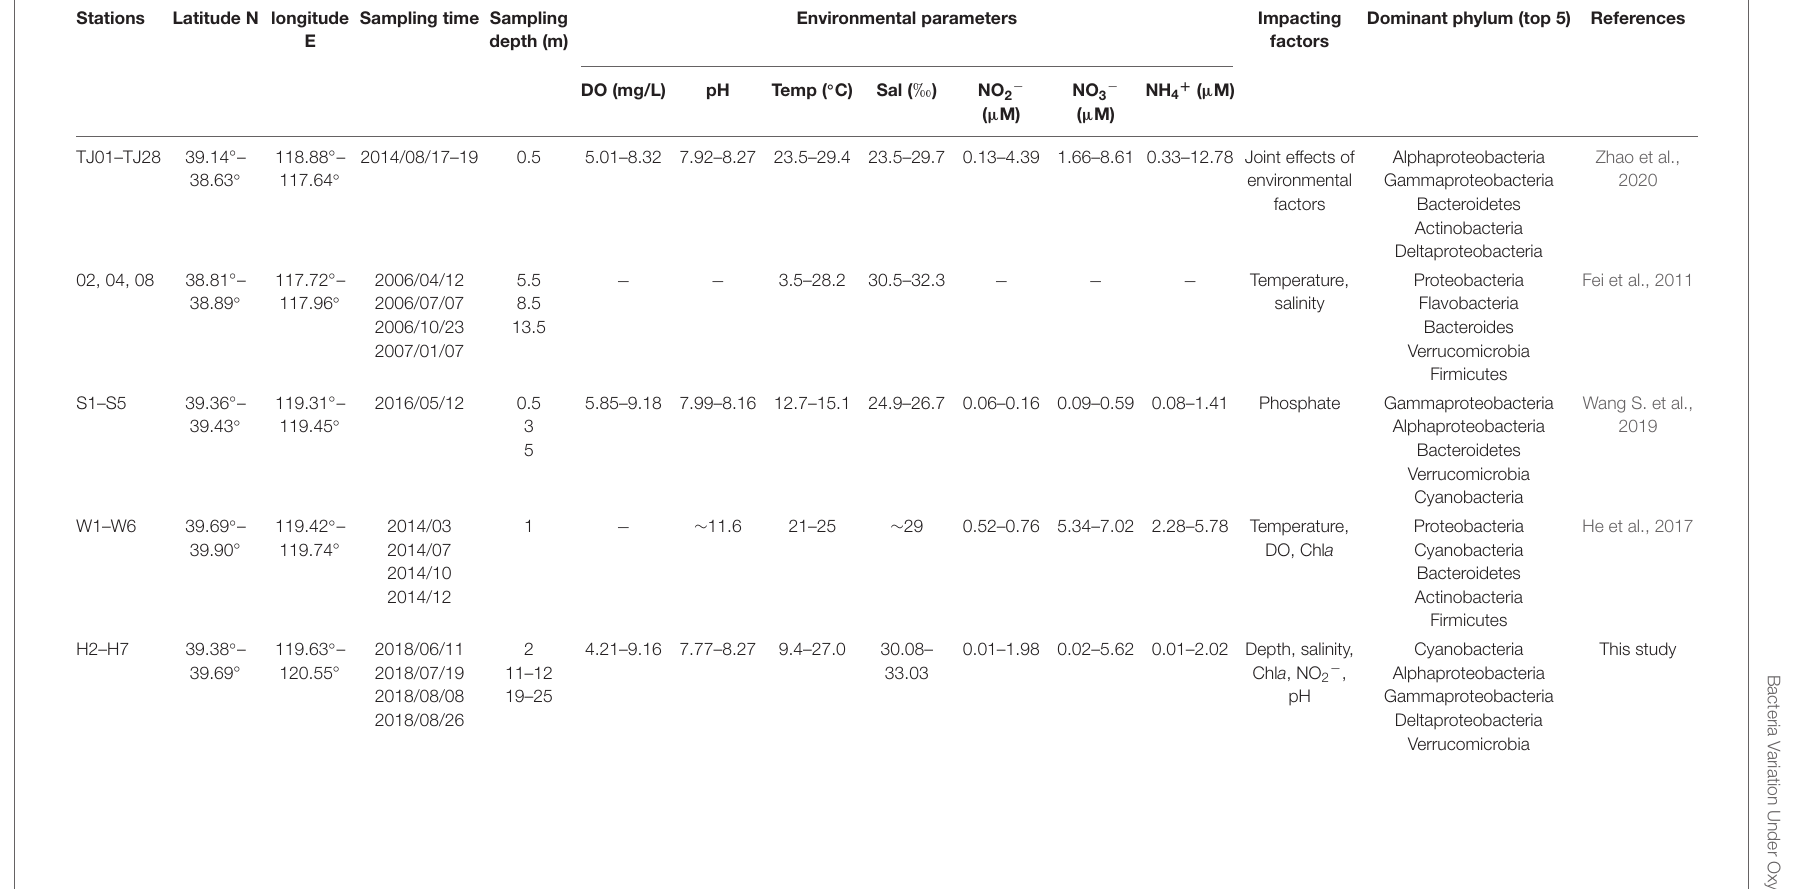
TABLE 1 | Summary of studies on bacterial diversity and distribution in Bohai Sea.